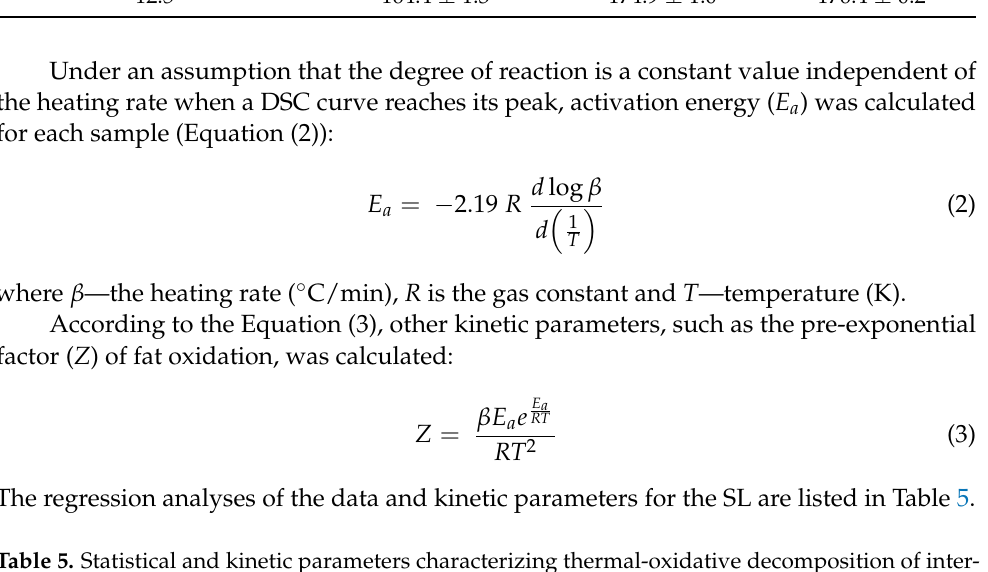
Table 5. Statistical and kinetic parameters characterizing thermal-oxidative decomposition of